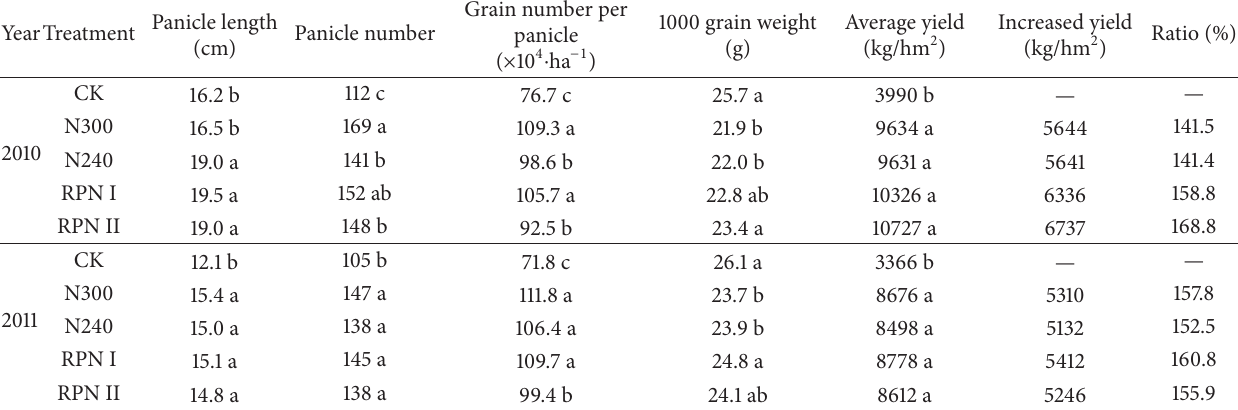
Table 3: Effect of RPN on rice yield and its components.